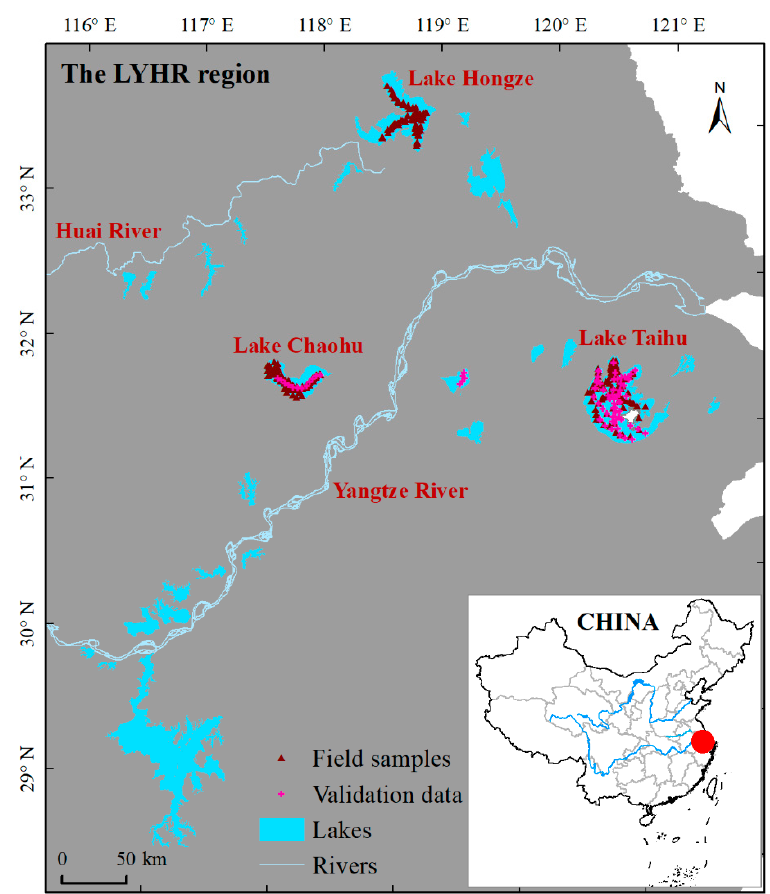
Figure 1. Location of the lakes in the lower reaches of the Yangtze and Huai River (LYHR) Basin. The field samples of Lake Chaohu, Lake Taihu, and Lake Hongze were collected from 2011 to 2017. The validation data were match-up pairs of field data and Ocean Land Color Instrument (OLCI)-derived data.